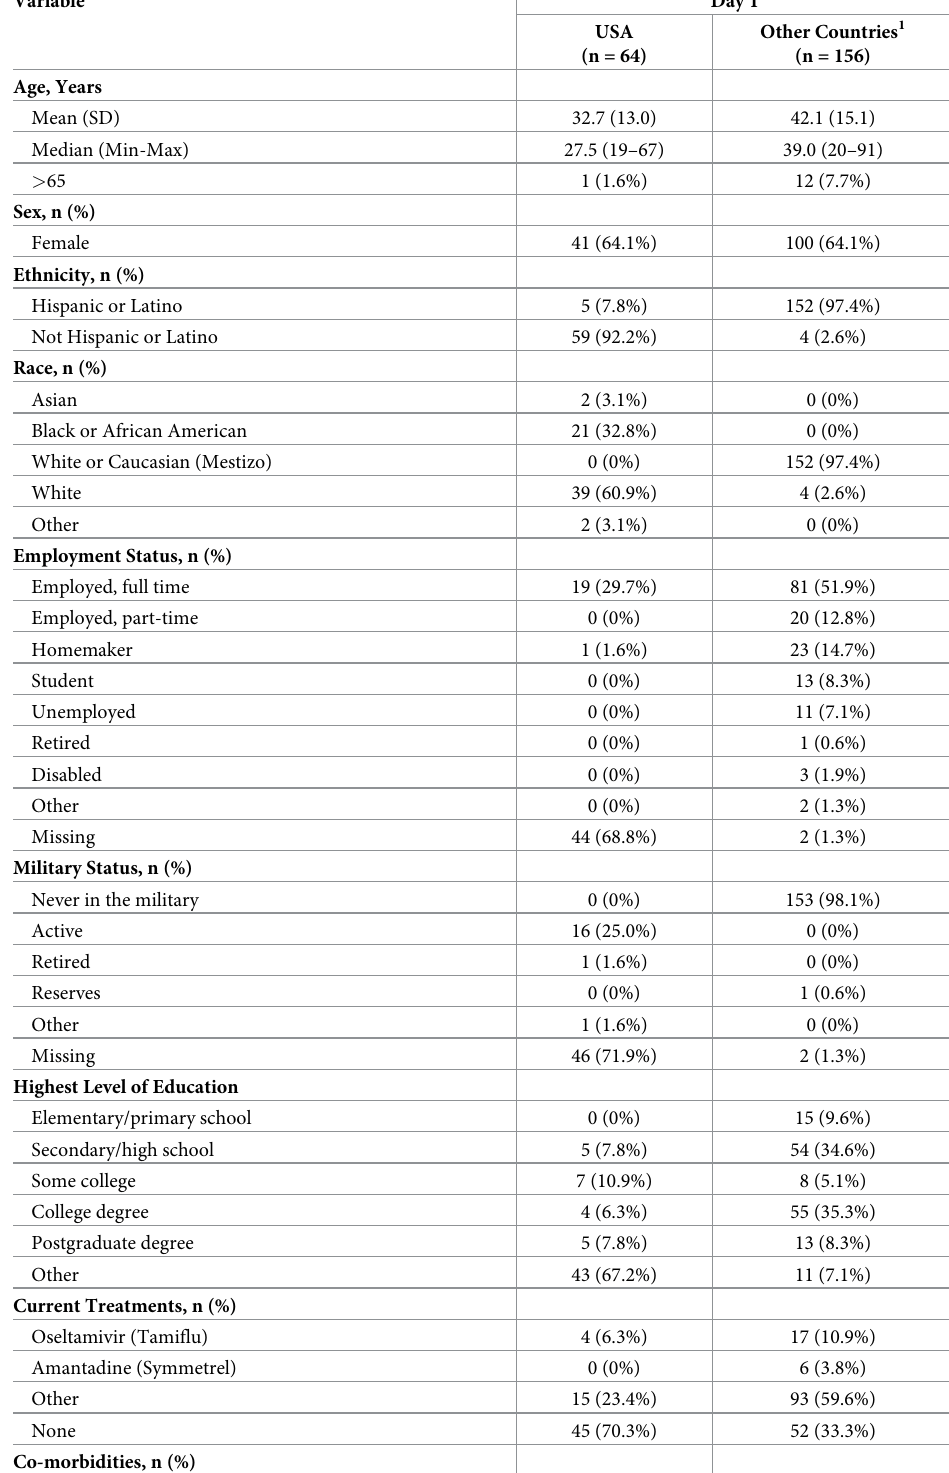
Table 1. Patient demographic characteristics by region in patients with influenza like illness (N =